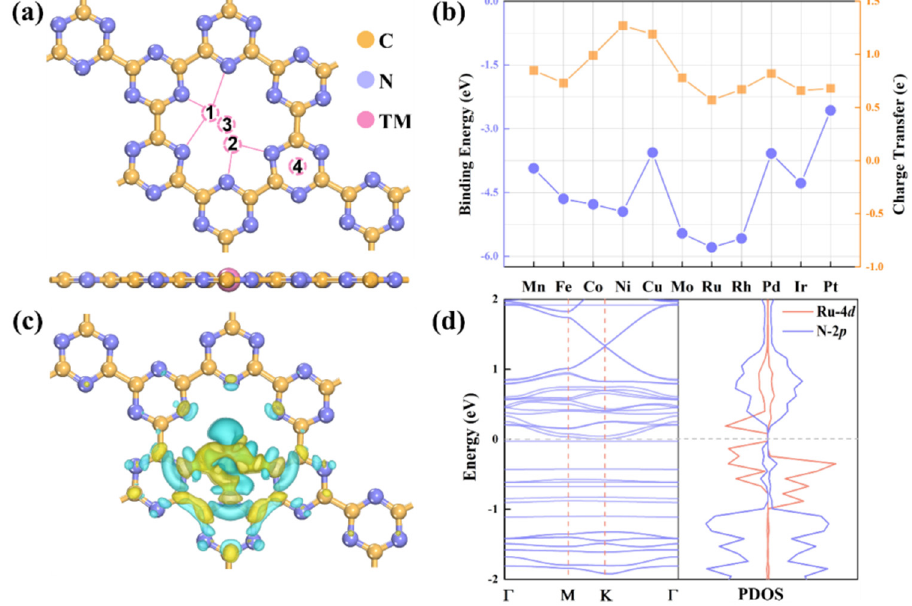
Figure 1. ( a ) The top and side views of TM/g-CN structure after full relaxation. ( b ) Binding energies Figure 1. a) The top and side views of TM/g–CN structure after full relaxation. b) Binding energies and Bader charge transfer of different atoms on g-CN. ( c ) The charge density difference of Ru/g-CN and Bader charge transfer of different atoms on g–CN. c) The charge density difference of Ru/g–CN with an isovalue of 0.003 e Å − 3 . d) The computed band structure and projected density of states of with an isovalue of 0.003 e Å − 3 . ( d ) The computed band structure and projected density of states of Ru/g–CN. The Fermi level was set to zero, indicated by the dashed line. Ru/g-CN. The Fermi level was set to zero, indicated by the dashed